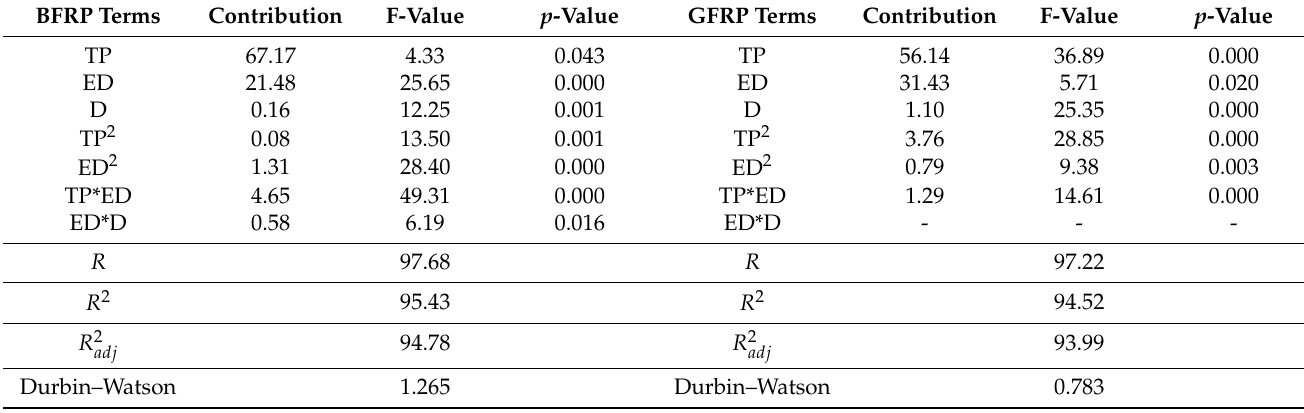
Table 4. ANOVA results of the